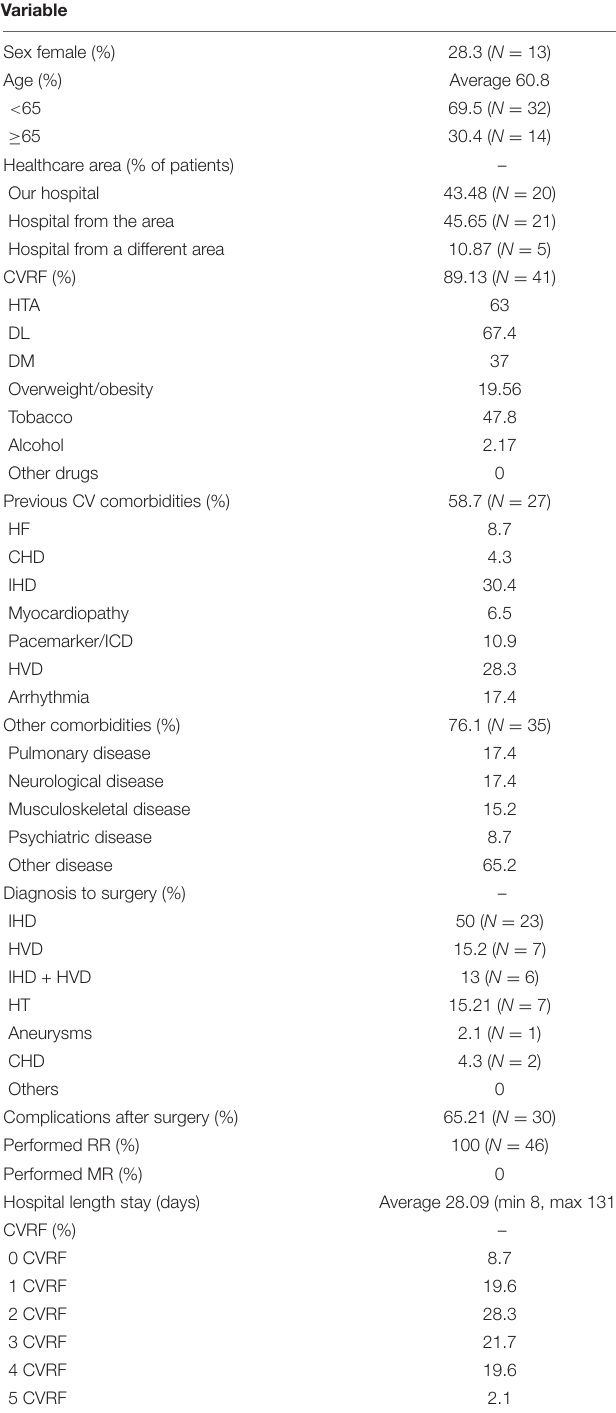
TABLE 2 | Characteristics of patients referred to the phase II